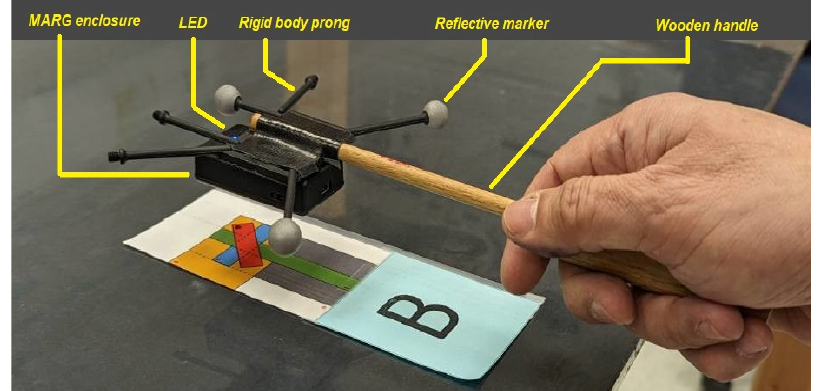
Figure 2. Wand assembly manipulated by the volunteer subjects, shown in Pose 1 <Default Pose> over location (B).